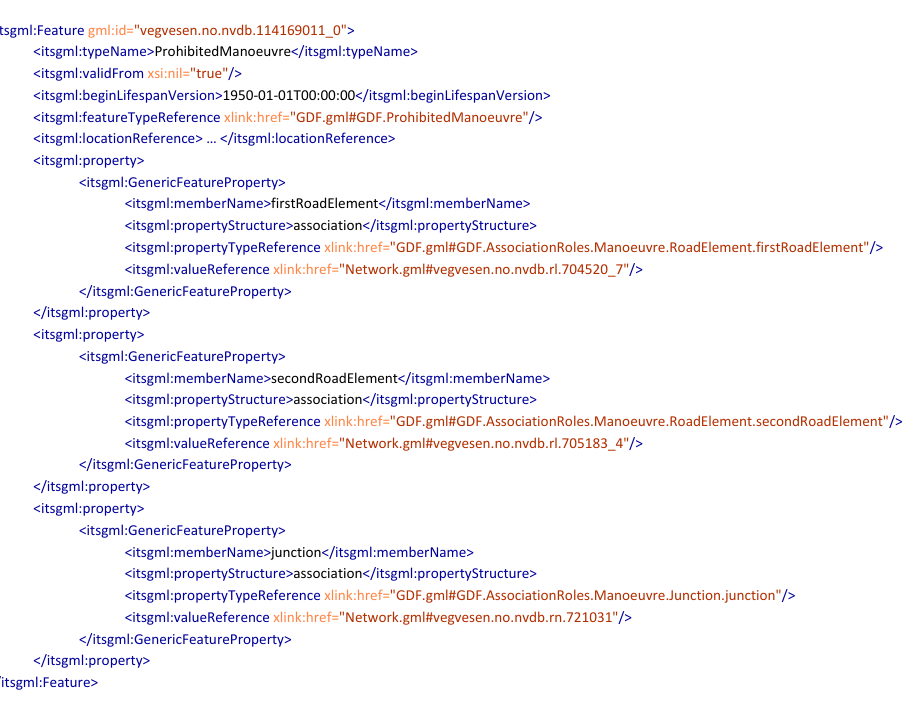
Figure 16. Extract of the GDF Feature Exchange GML file with an instance of the ProhibitedManoeuvre feature type. ISPRS Int. J. Geo-Inf. 2018 , 7 , x FOR PEER REVIEW